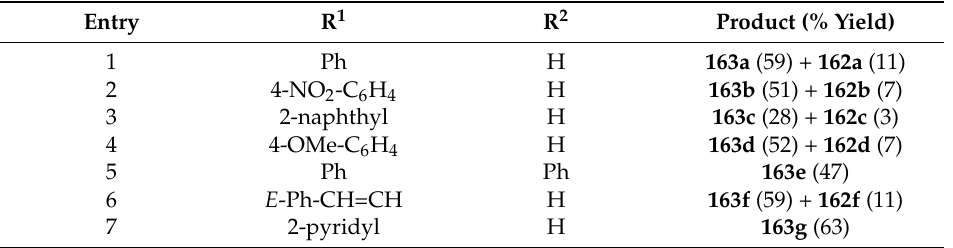
Table 21. Cycloaddition of azomethine ylide 160 to aldehydes and a ketone (Scheme 39).